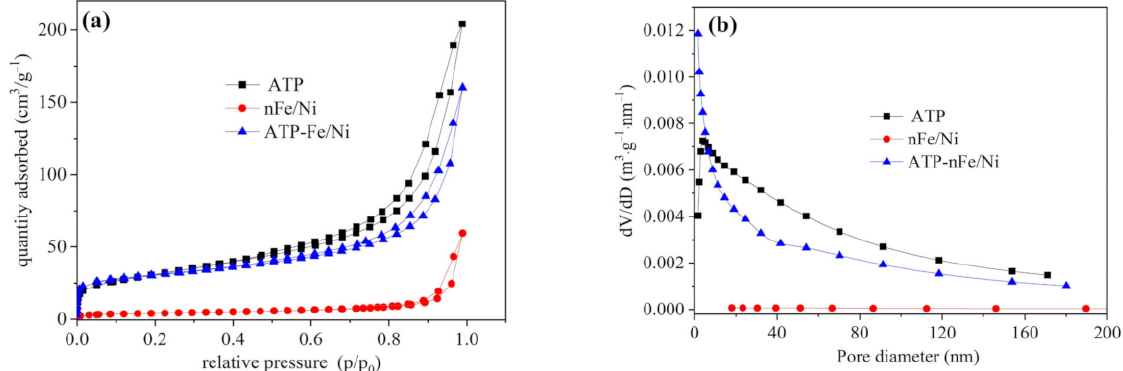
Figure 3. N 2 adsorption–desorption isotherms ( a ) and pore diameter distribution curves ( b ) of ATP, nFe/Ni and